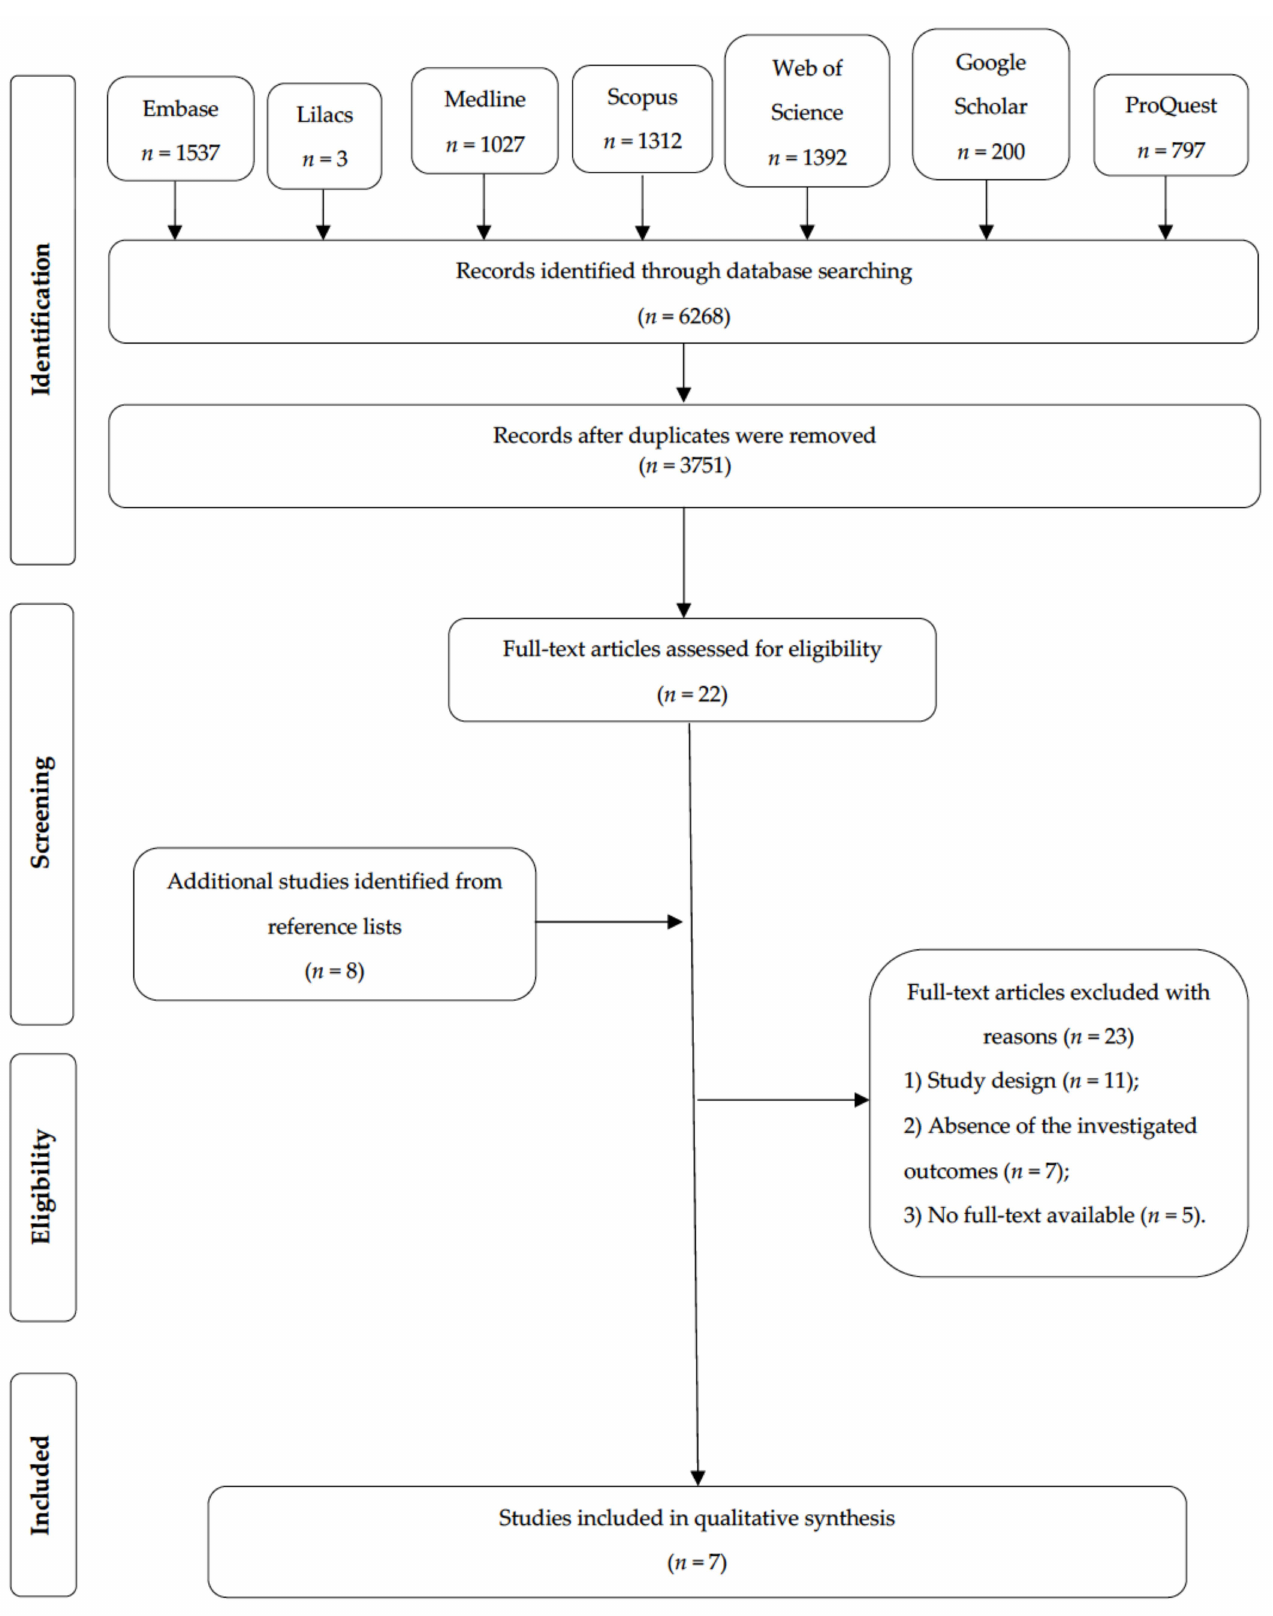
Figure 1. Flow diagram of the literature search and selection